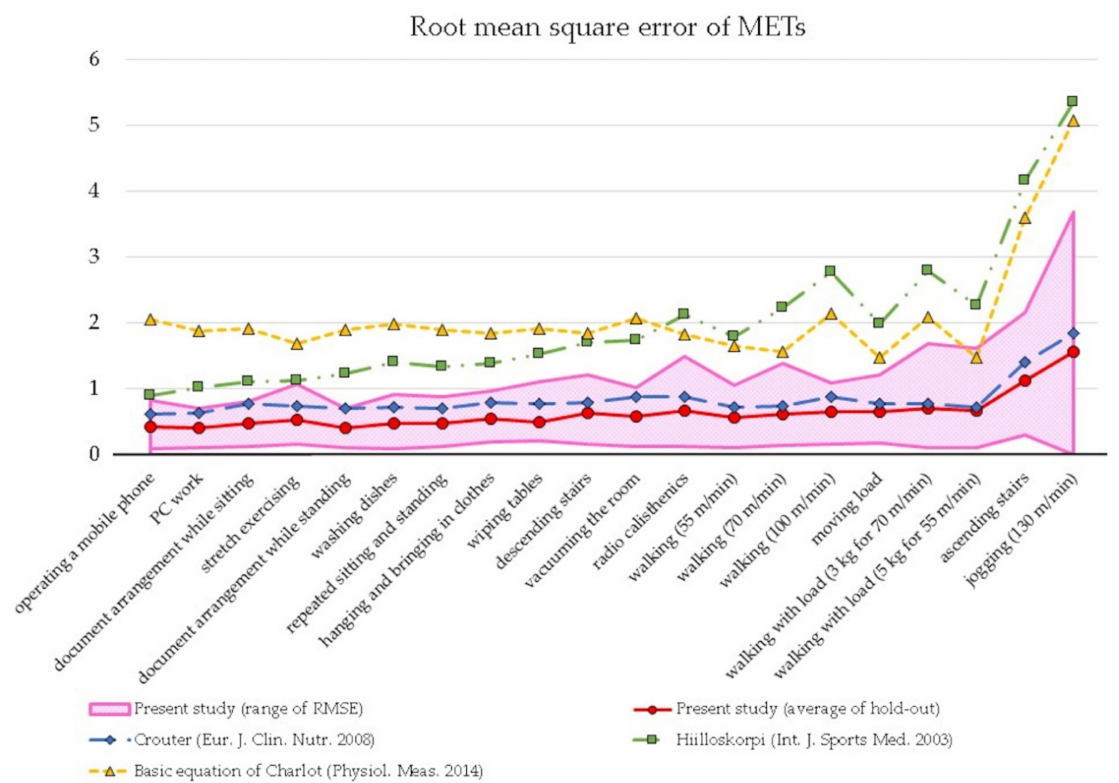
Figure 4. Comparison of prediction errors expressed as RMSE with those of previous studies.